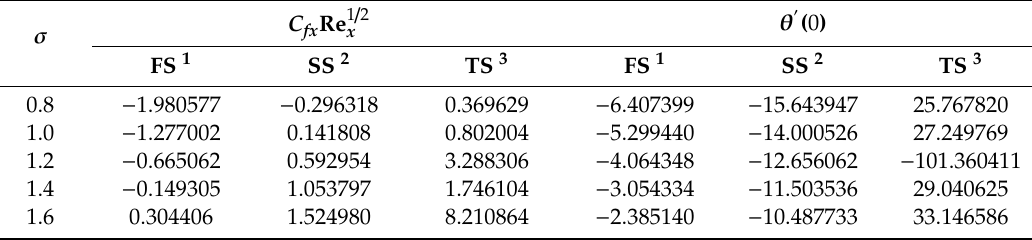
(cid:48) ( and θ 0 ) . The x